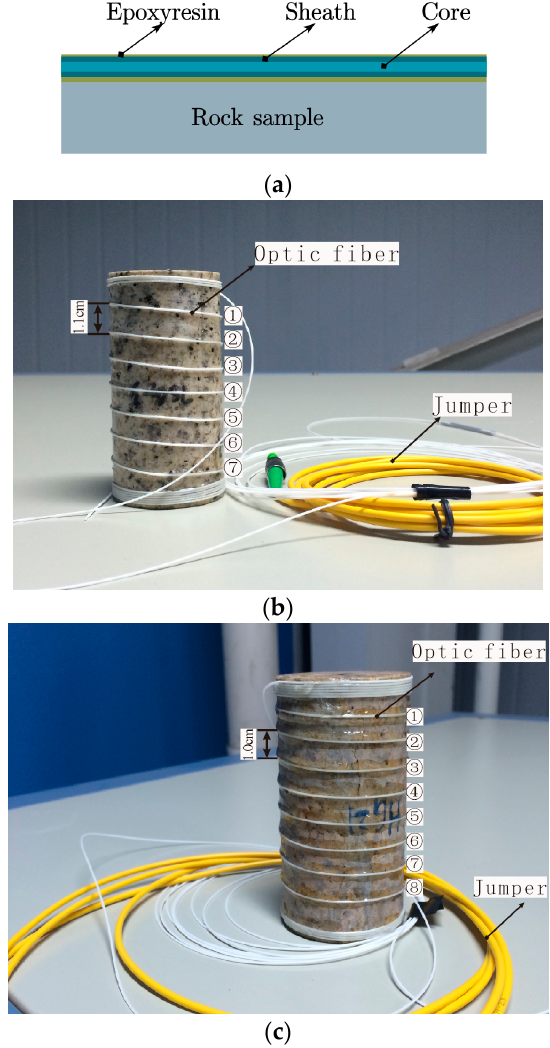
Figure 3. Layout description of optical fiber sensors; ( a ) shows the optical fiber pasting method; ( b ) and ( c ) show the optical fiber arrangement on the surface of sample No.0 and No.3.